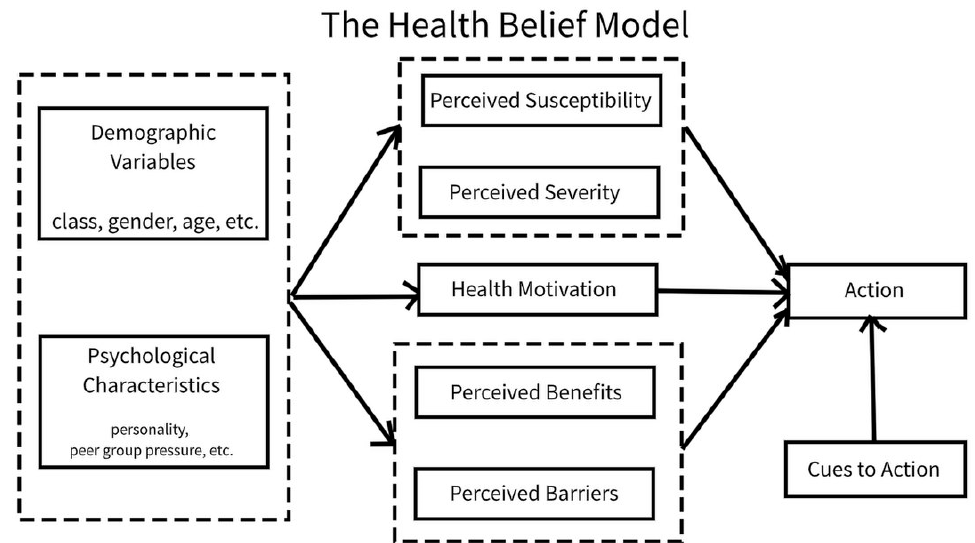
Figure 2. The Health Belief Model (HBM) by Rosenstock (1966) [26] was used in this study to explore the factors driving and inhibiting making healthy food choice. The diagram is produced by an unknown author and licensed under CC BY-SA for public use.